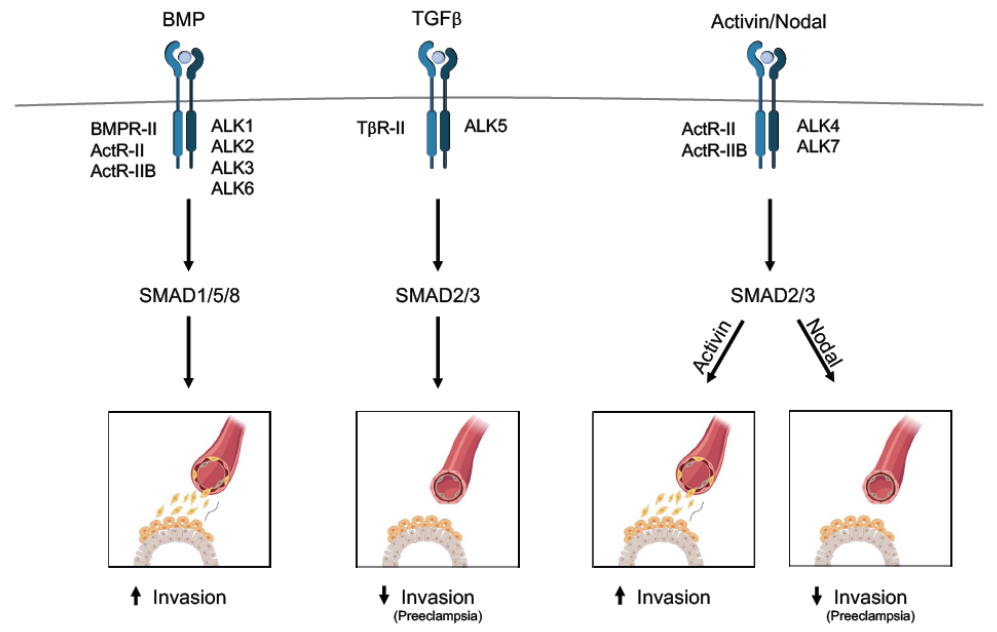
Figure 4. The proposed role of the TGFβ family in human placental development at the fetal–maternal interface. The TGFβ members signal by binding to receptor complexes type I (activin receptor-like kinase (ALK)) and type II receptor, depicted for each ligand. Upon receptor activation, the SMADs are phosphorylated and form complexes with SMAD4 to translocate into the nucleus, where they bind and initiate transcription of their target genes. The main members of the TGFβ family (TGFβ, bone morphogenetic protein (BMP), activin, and Nodal) have opposite roles in human placentation, either promoting or inhibiting trophoblast (TB) invasion. Hence, upregulation of TGFβ and